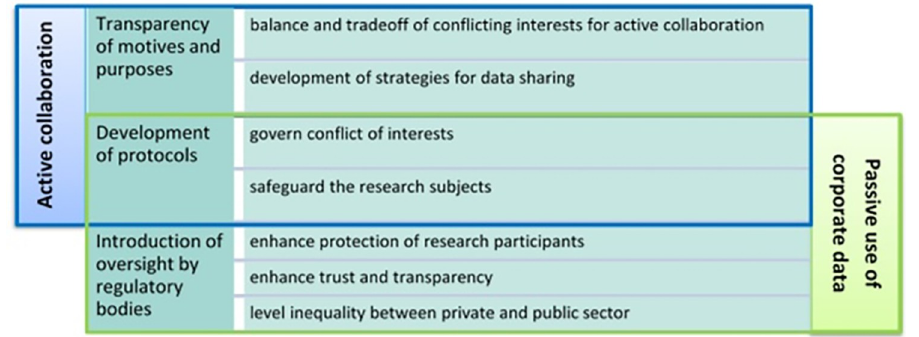
Fig 1. Suggestions to foster sustainable academic-corporate